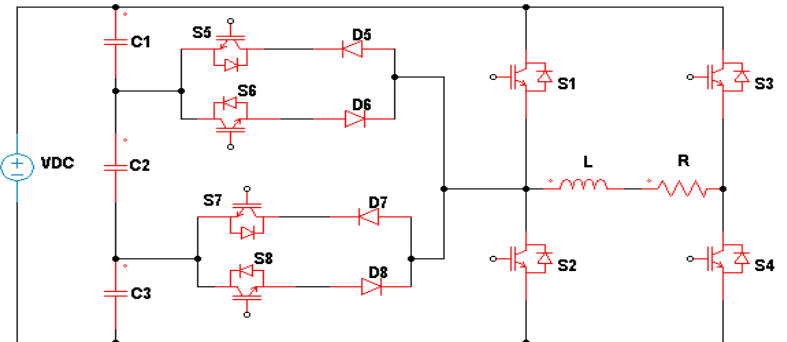
Figure 3. T-type seven-level inverter with blocking diodes.